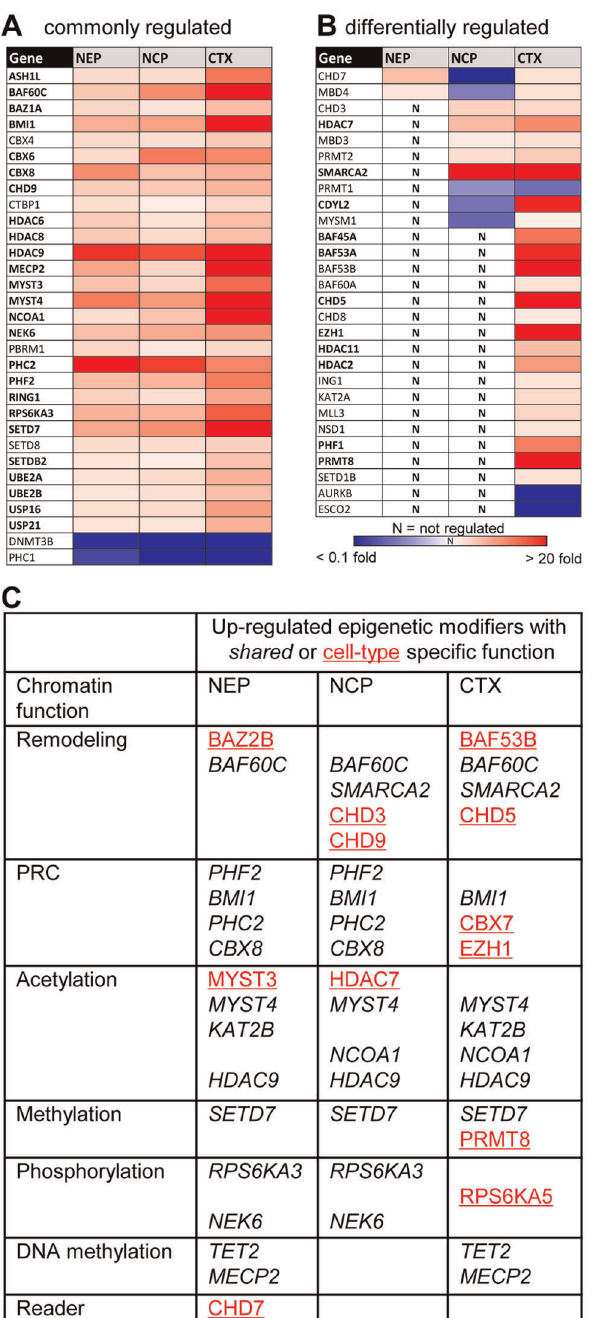
Figure 6. Comparison of epigenetic modifiers in cortical neurons with early neural precursors. The levels of epigenetic regulator gene transcripts were measured as in Fig. 5, but samples from human cortex (CTX) were included. Up-regulated genes are displayed in red, down-regulated transcripts in blue, as indicated by the chromatic scale. Genes with CTX transcript levels 5 times higher than in hESC are indicated in bold letters (A) Display of all genes regulated into the same direction in early neural precursors and mature neurons. (B) Differen- tially regulated genes. Measures of variance and p-values are indicated in the supplemental material. (C) Summary of the most up-regulated common (italics) or cell type-specific (red, underlined) chromatin modifier genes, sorted according to their function.